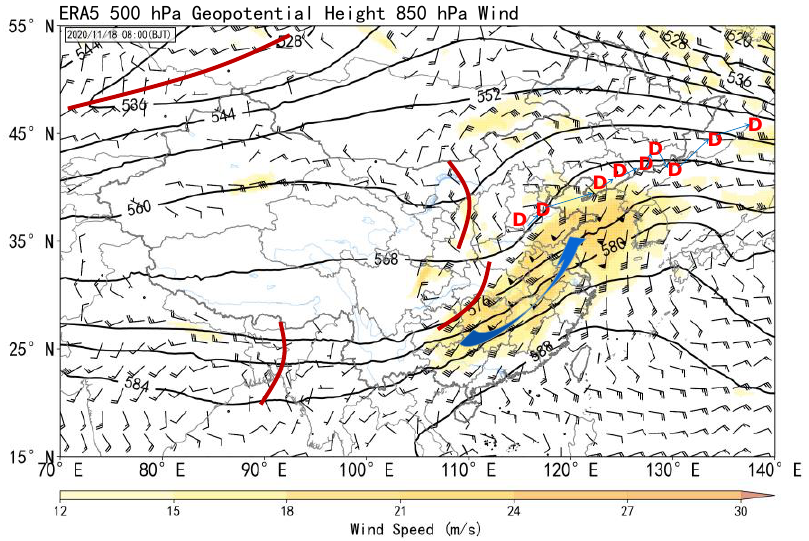
Figure 2. 500 hPa height field (black isoline, brown line is trough line) and 850 hPa wind field at 08:00 on 18 November, the blue arrow line is 850 hPa jet core, “D” is the center of ground low pressure every 6 h from 08:00 on 18 November to 08:00 on 20 November.